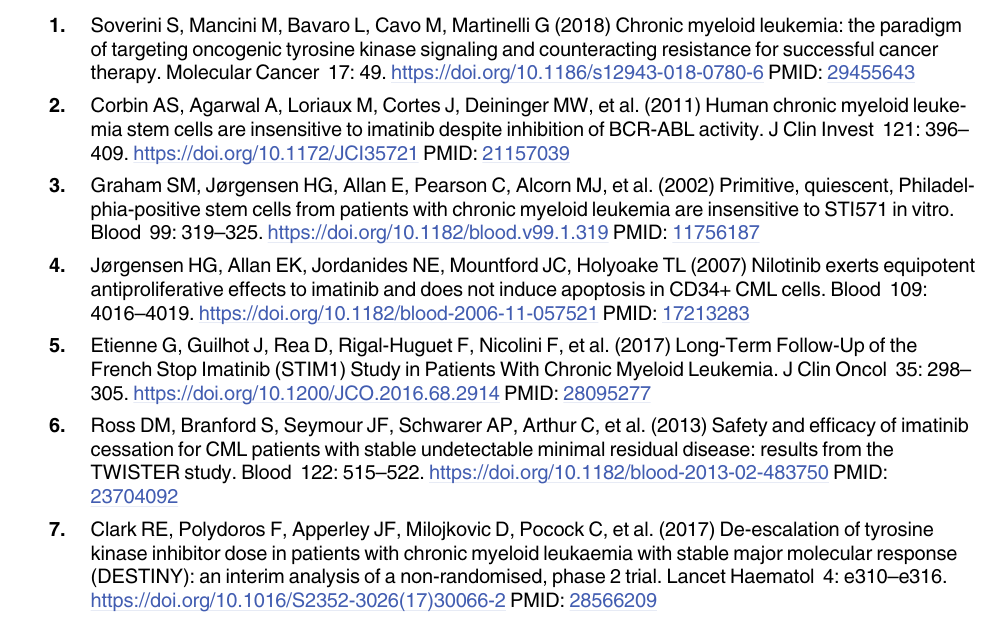
enrich CD34+ cells in GO from patients in chronic phase CML and healthy controls. RNA measurements were made utilising Affymetrix Human Genome U133 plus 2.0 arrays. Results are displayed as mean+/-SEM of log expression intensity (n = 5 for CML and n = 4 for normal 2 patients). SSRP1 shows on average a 3.4 fold increase in expression at the mRNA level in CML quiescent cells compared to quiescent cells isolated from healthy controls. The results of a t- test are shown �� < 0.01. S2 Fig. Original full images for western blots. Complete images for the western blots shown in Fig 5. Following incubation with the appropriate HRP-linked secondary antibodies and Supersignal West Pico Plus chemiluminescent substrate (ThermoScientific) protein expression was visualised on a Chemidoc XRS (BioRad) using Quantity One